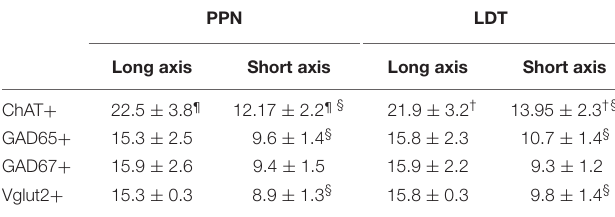
( Table 1 ). In relation to previously reported morphometrical data, the mean value of the long axis of the cholinergic neurons obtained here ( Table 1 ) was similar to most of the reported values (Spann and Grofova, 1992; Ford et al., 1995; Boucetta and